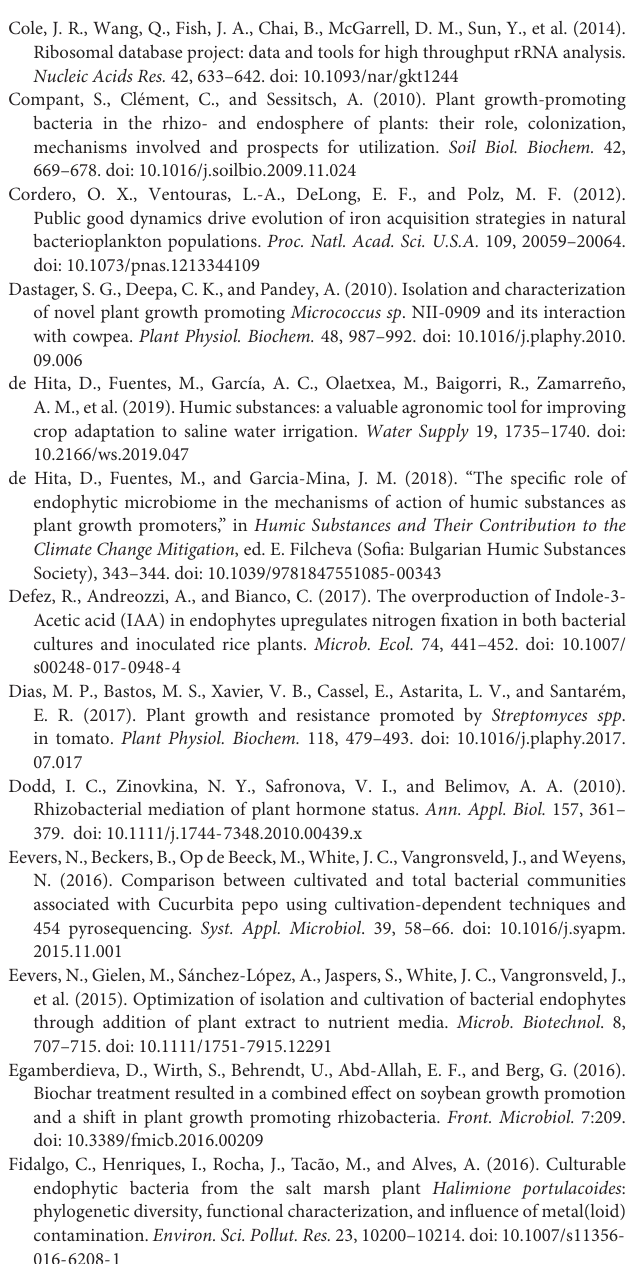
FIGURE S1 | Isolates distribution by phylum, class, order, and family. TABLE S1 | Identification and PGP characterization of endophytes extracted from SHA pre-treated cucumber plants. The identification used as reference databases the BLASTn and RDP Seq-Match assignment of 16S rRNA sequences. TABLE S2 | Inorganic phosphate solubilization (IPS) ratios for those isolates able to solubilize the inorganic phosphate after 7 or 14 days after incubation. TABLE S3 | Metallic chelation index (MCI) ratios for those isolates producing siderophores after 7 days of incubation. FILE S1 | 16S partial sequences of the